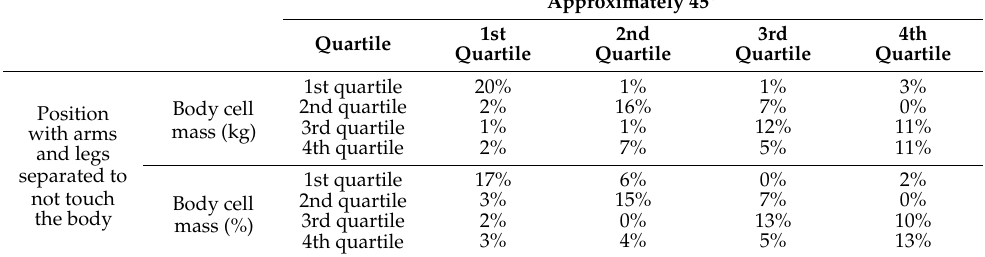
Table 3. Analysis of the quartile distribution of the body cell mass results in the studied group of Caucasian young normal body mass women measured in the follicular phase in various positions (with arms abducted at least 30 ◦ and legs abducted at approximately 45 ◦ ; with arms and legs separated to not touch the